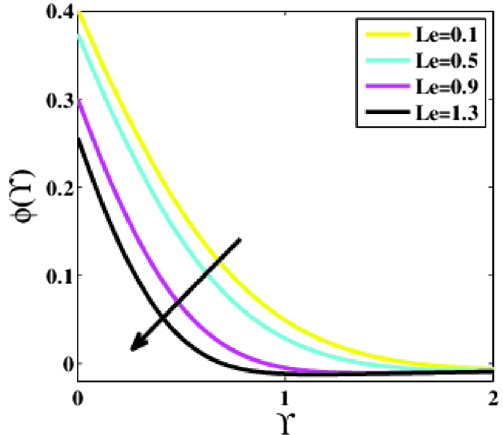
Figure 21. Plots of φ(ϒ) for Le .